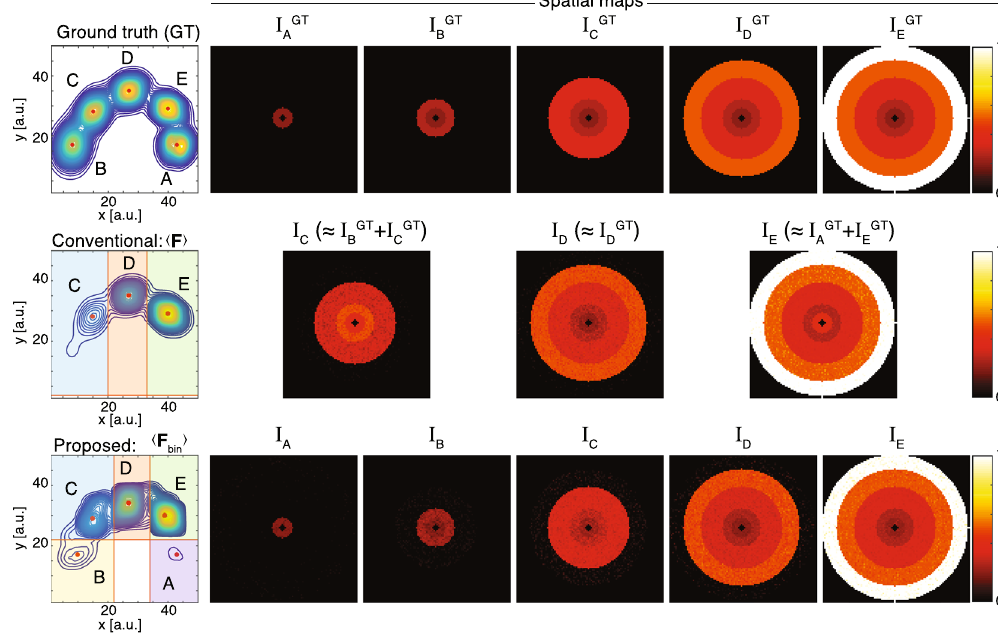
Figure 3. Numerical simulations results. The spectrum on the top row shows the 5 ground truth spectral components unweighted by their prevalence in the image, with their corresponding ground truth spatial images. Results from using the conventional approach to processing spectral imaging data are shown on the center row. F is simply an average spectrum across the entire image, and as such, it does not contain components A and B, and therefore cannot be used to correctly reconstruct the ground truth images. The bottom row shows the application of the suggested sROI generator, and its successful identification and reconstruction of the ground truth